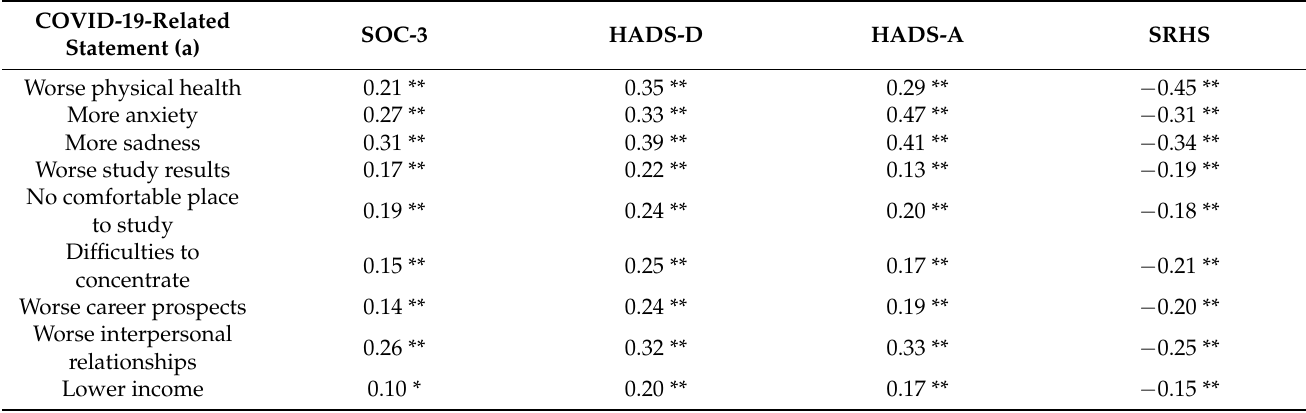
Table 3. Spearman’s correlation coefficients between questions related to the COVID-19 pandemic, SOC-3, HADS scales and self-reported